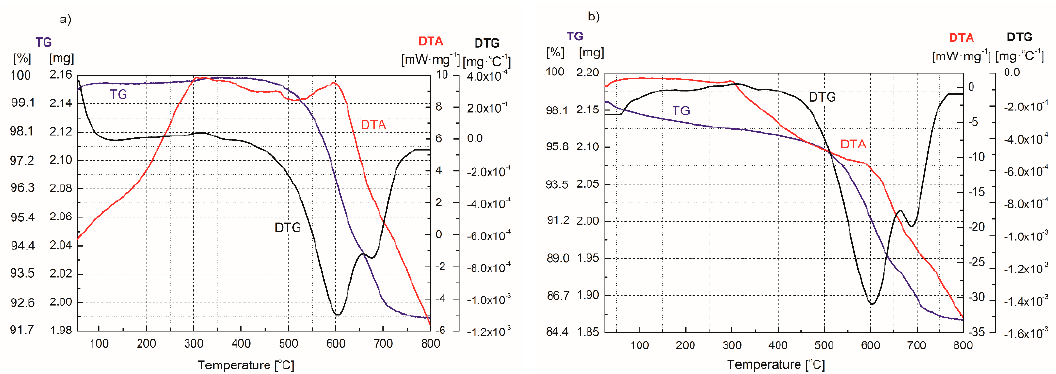
Figure 5. Differential thermal analysis (DTA), thermogravimetric analysis (TG) and differential thermogravimetric analysis (DTG) curves of ( a ) raw FA and ( b ) H 2 O 2 -treated FA.